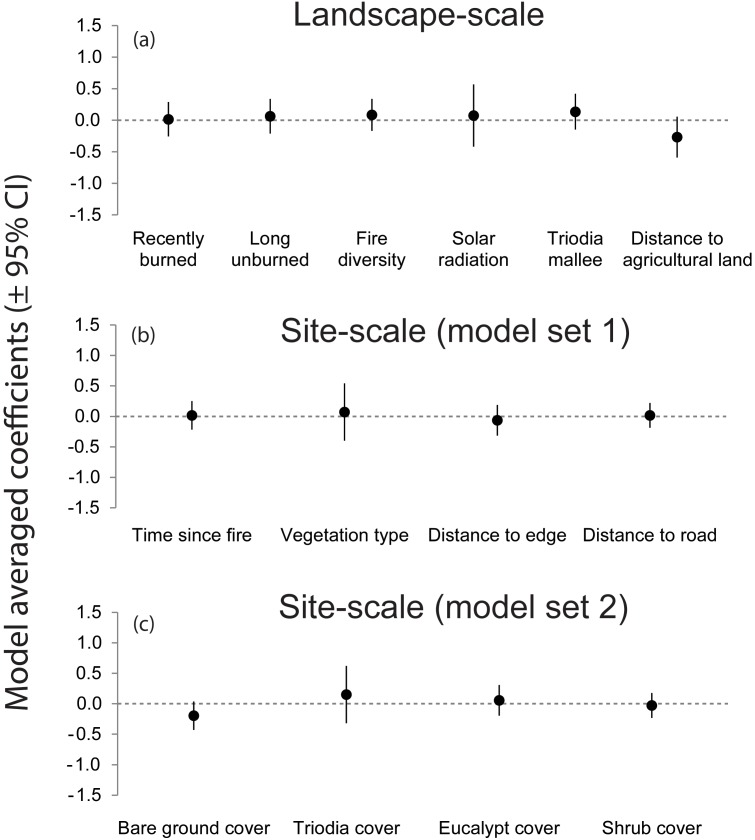
Model-averaged regression coefficients and 95% confidence intervals of models describing the reporting rate of foxes at both the landscape-scale (a) and site-scale (b and c).